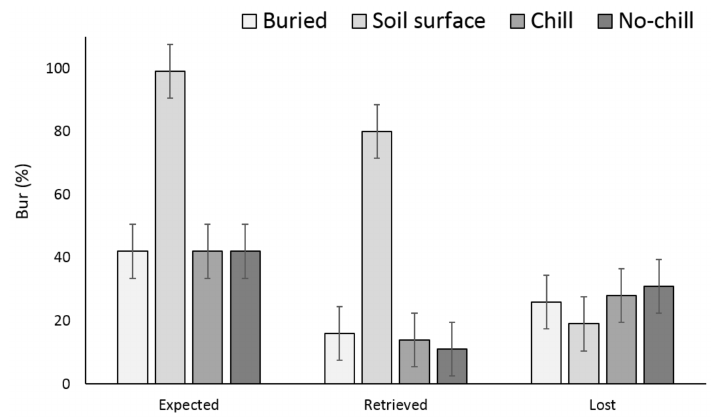
Figure 3. Effect of environmental conditions on X. strumarium bur loss originating from a single maternal source after three years. Vertical bars represent LSD at 5% significance level. Expected is the sum of non-germinated seeds.